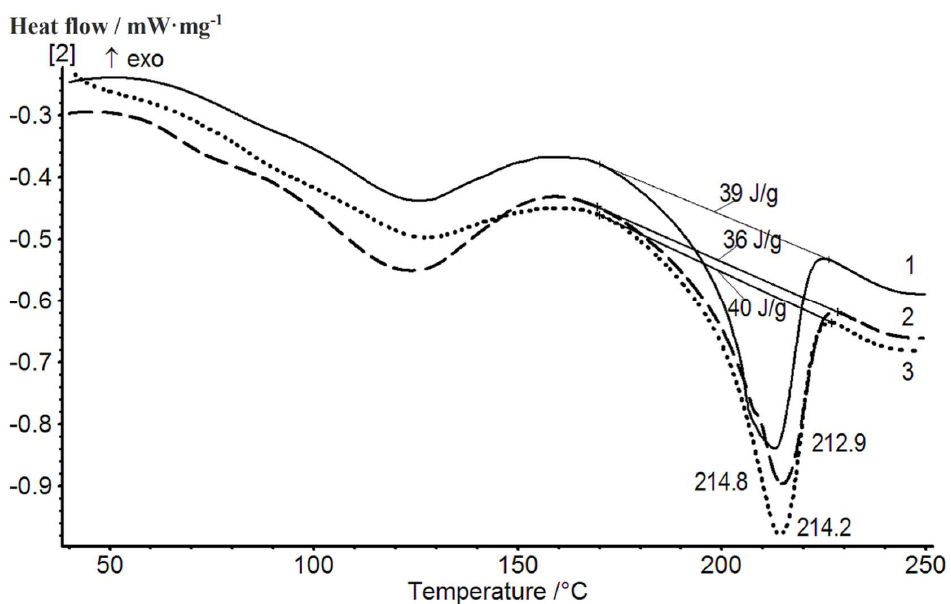
Figure 13. Thermograms of samples of the 80/20 PVA-PAA compositions obtained in mode 1 (composition 1): 1—the original composition; 2—composition containing 1 wt.% of carbon NTs with surface carboxyl groups; 3—composition containing 1 wt.% of untreated carbon NTs.